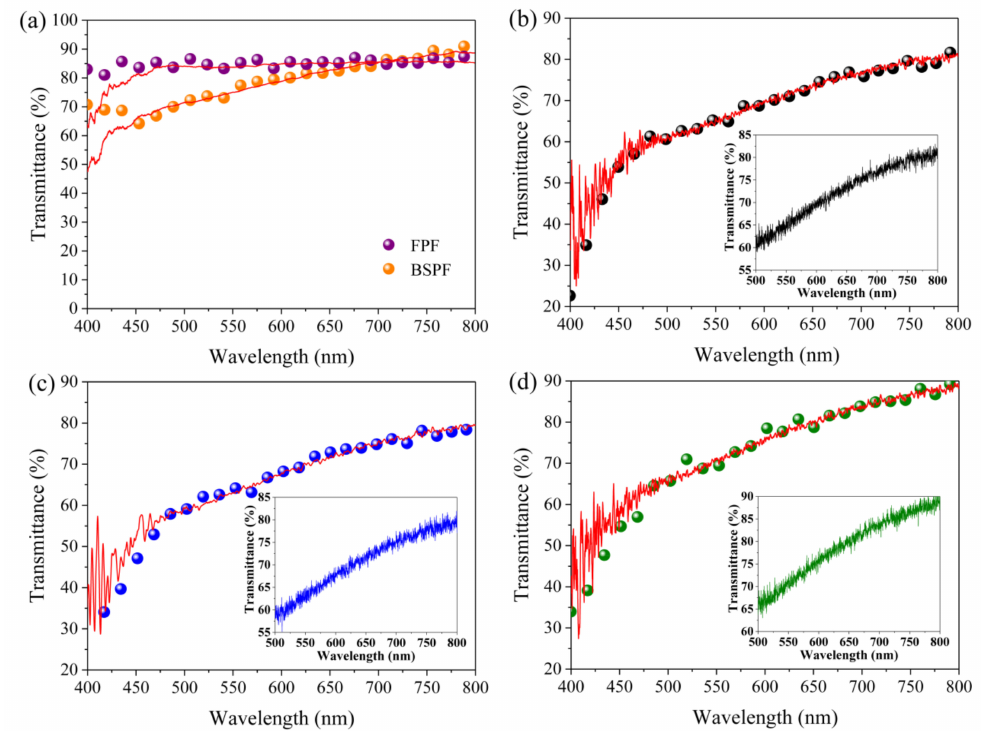
Figure 9. ( a ) Initial transmittance spectra of the FPF (purple) and BSPF (orange) before spray simulation; ( b ) transmittance of the BSPF changes after spray simulation for 30 s; ( c ) transmittance of the BSPF changes after spray simulation for 60 s; ( d ) transmittance recovers to initial fog-free state after continuous spray simulation for 90